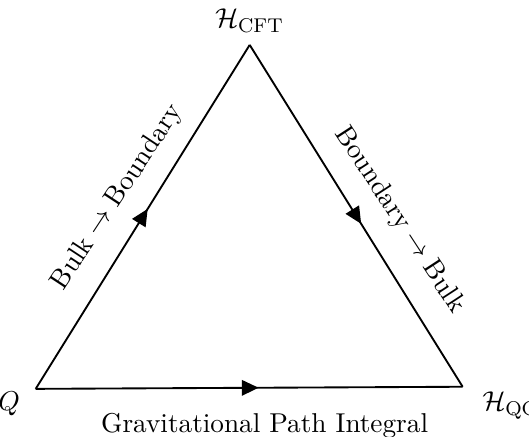
Figure 8 . The GHP implies that this triangle diagram commutes, i.e. the composition of the bulk → boundary map and the boundary → bulk map, is equivalent to the gravitational path integral, which maps states in the quotient kinematic space Q to the constrained state space H